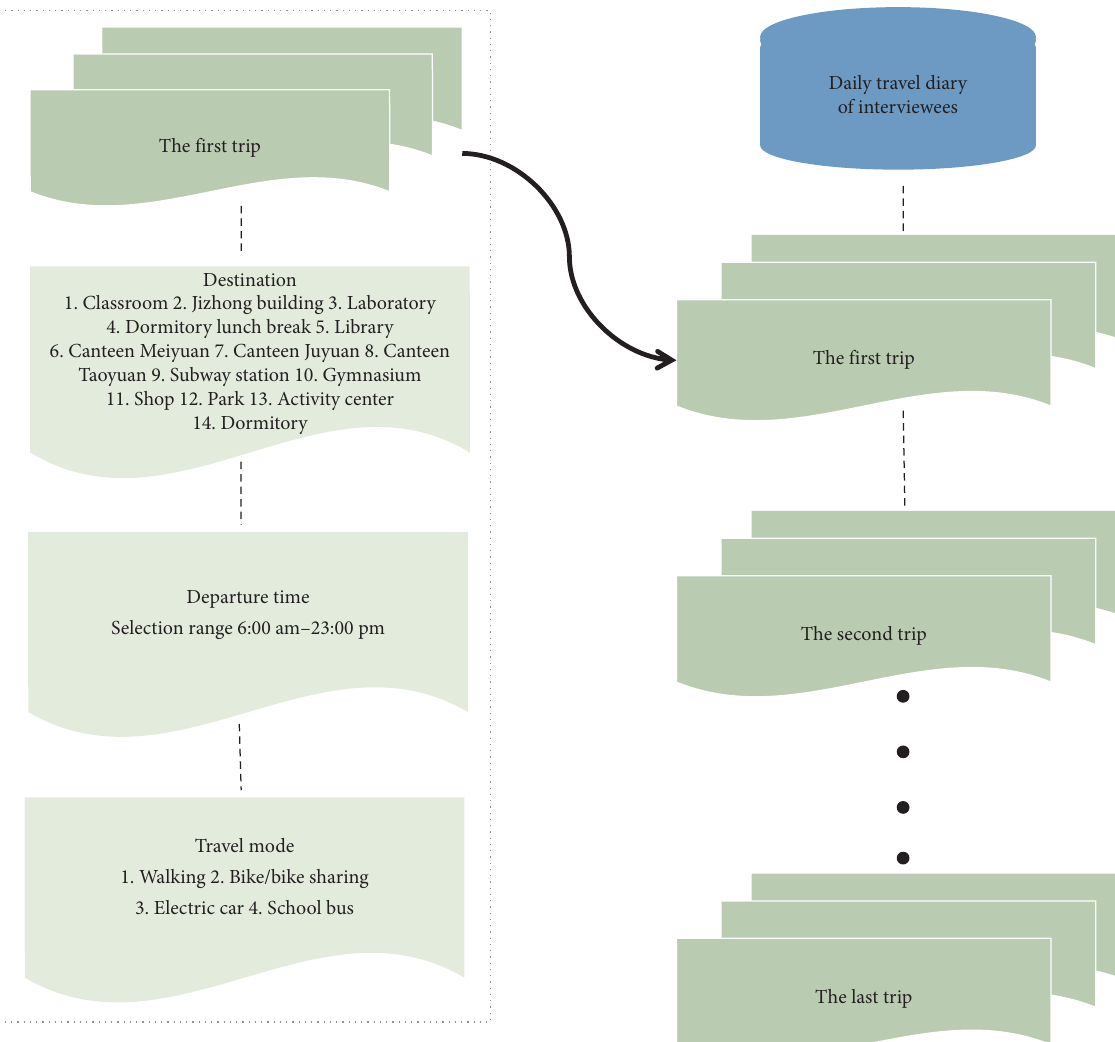
Figure 4: Structure of travel diary survey in RP